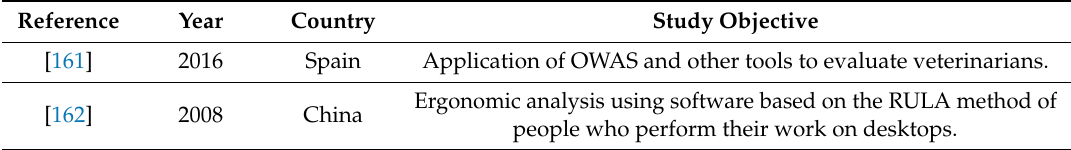
Table 13. Professional, scientific and technical